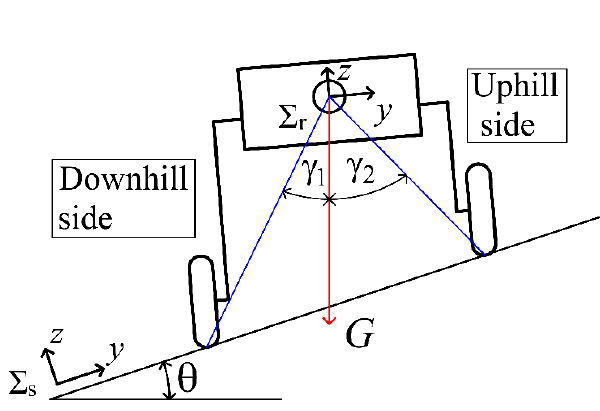
Figure 7. Lateral stability margins for the robot.